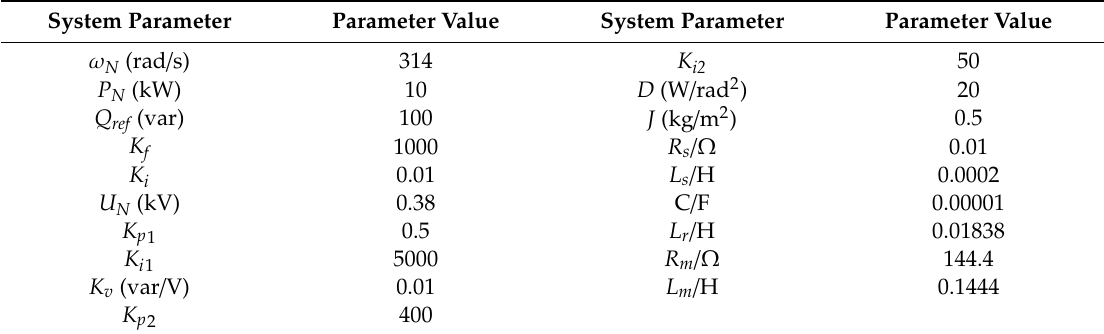
Table A1. Parameter of the